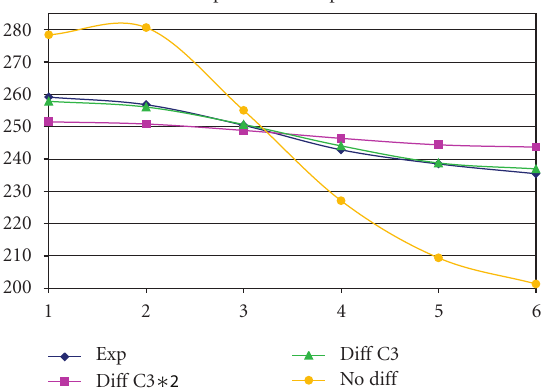
Figure 10: Rod power distribution in fluid temperature measure- ment tests; red rod power 100%, yellow 25%. Figure 11: Sensitivity of the temperature profile to the turbulent di ff usion